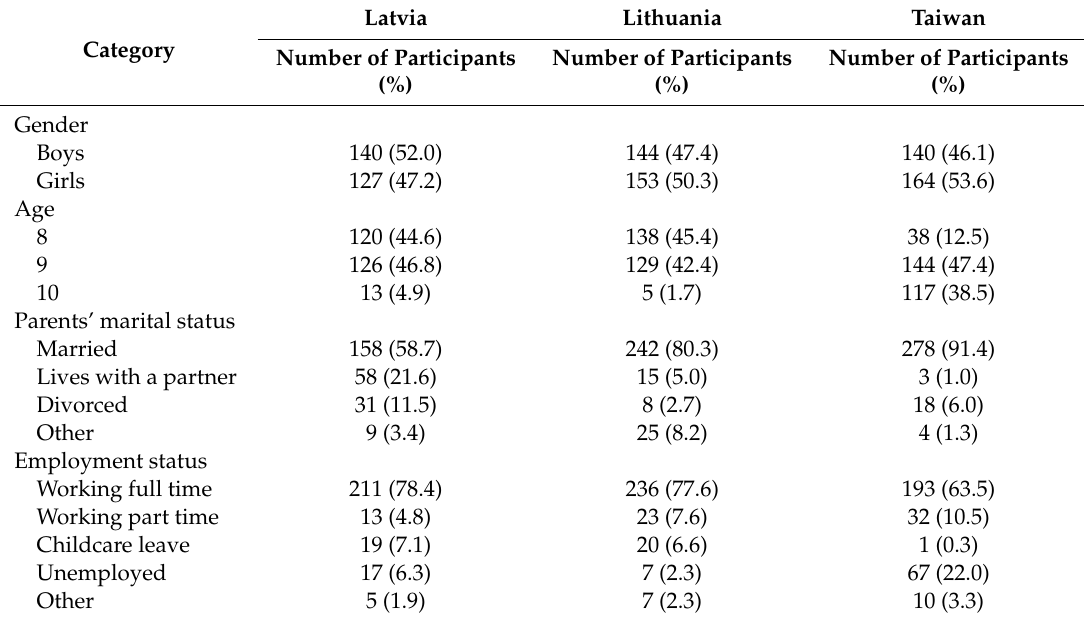
Table 1. Characteristics of the